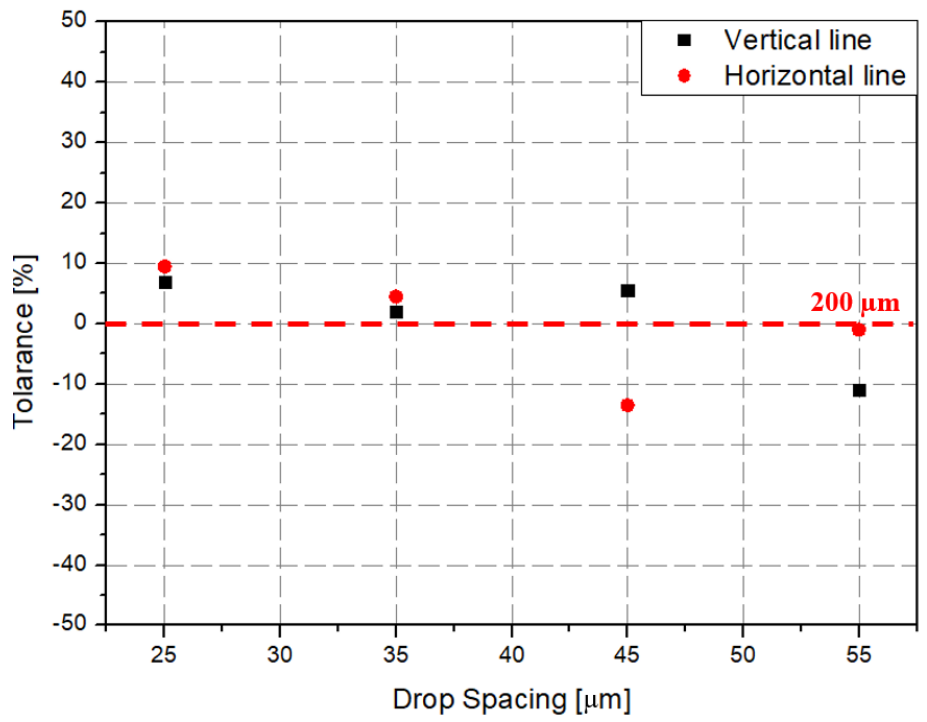
Figure 6. Comparison graph of vertical and horizontal line tolerance varying to the drop spacing.